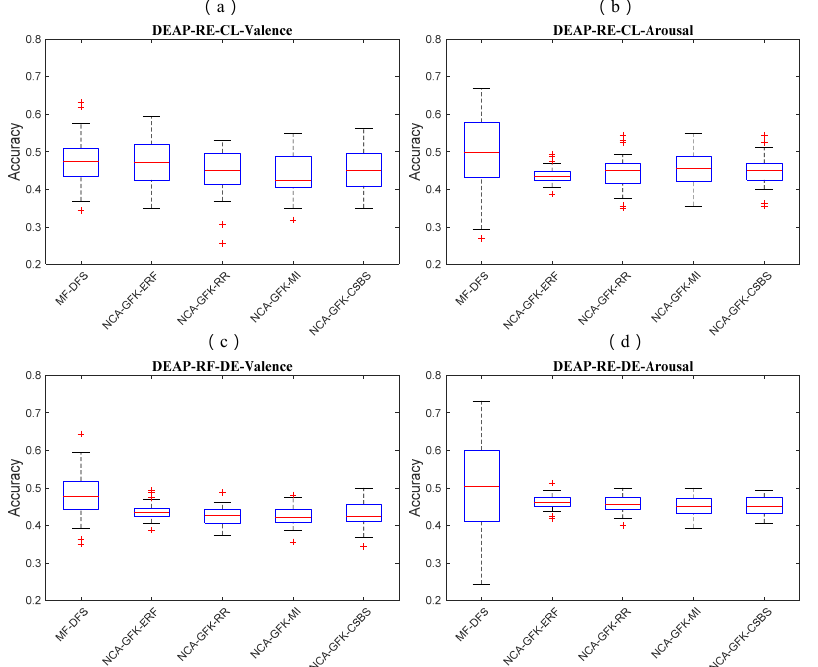
Figure 4. Boxplots of the classification accuracy based on the RF classifier combined with five feature selection methods of the DEAP database. The accuracies of CL features for the valence and arousal dimensions are shown in ( a , b ), respectively. The accuracies of DE features for the valence and arousal dimensions are shown in ( c , d ), respectively.